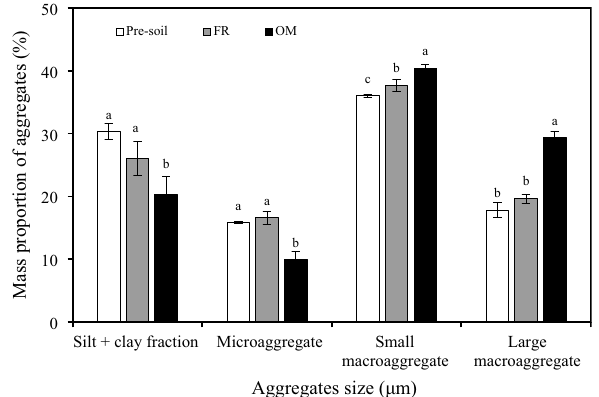
Figure 1. Mass proportion of aggregates in different treatments. Vertical bars denote the standard error of the mean (n = 3). Different letters a, b and c indicate significant differences between treatments for the same aggregate at p < 0.05. FR, chemical fertilizer; OM, organic